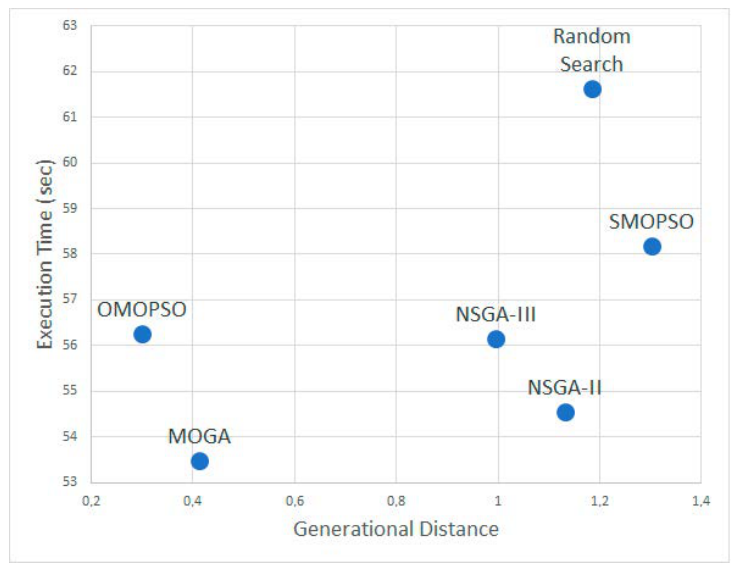
Figure 14. Plot chart mapping the studied algorithms according to the ET and the GD .